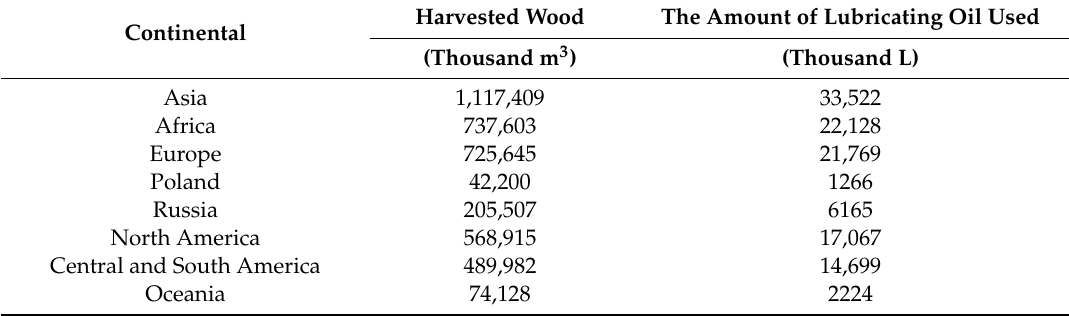
Table 1. Comparison of harvesting of wood and used oil divided into continents and specified for Poland in 2017